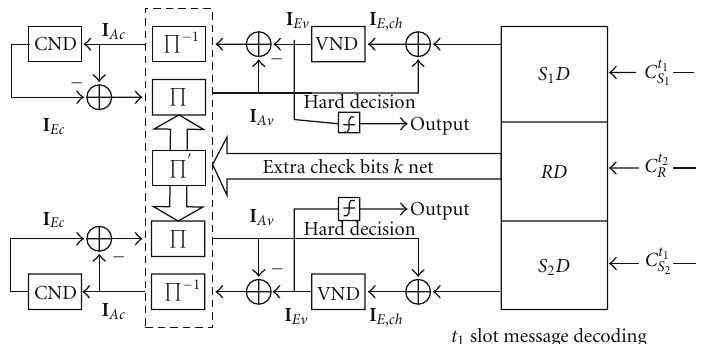
Figure 7: Decoder structure for joint decoding of C SR